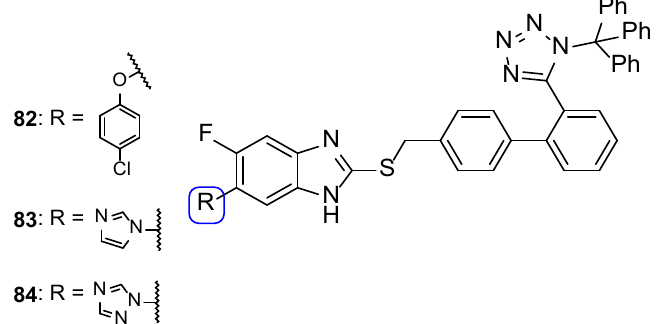
Figure 41. Chemical structures of compounds 82 – 84 [121].